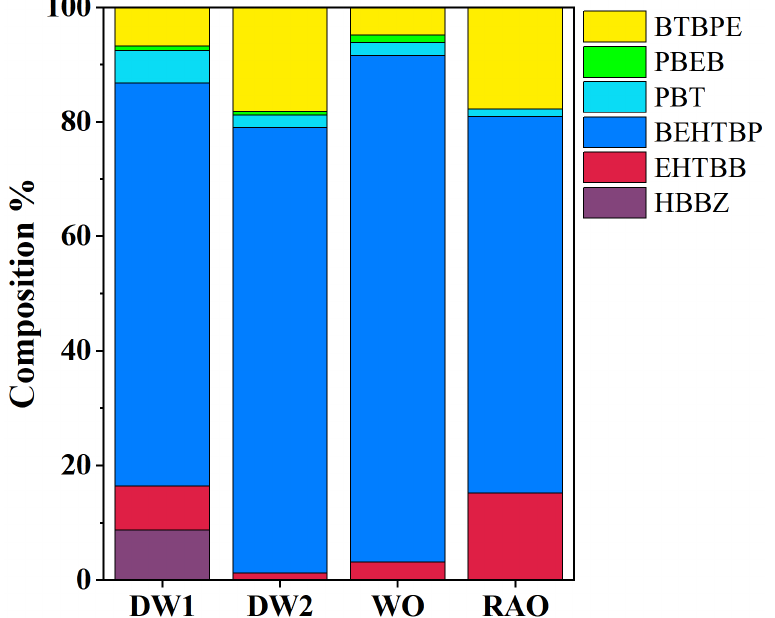
Figure 1. Composition profiles of NBFRs in dust samples from dismantling workshop 1 (DW1), dismantling workshop 2 (DW2), workshop outdoor (WO), and residential area outdoor (RAO).